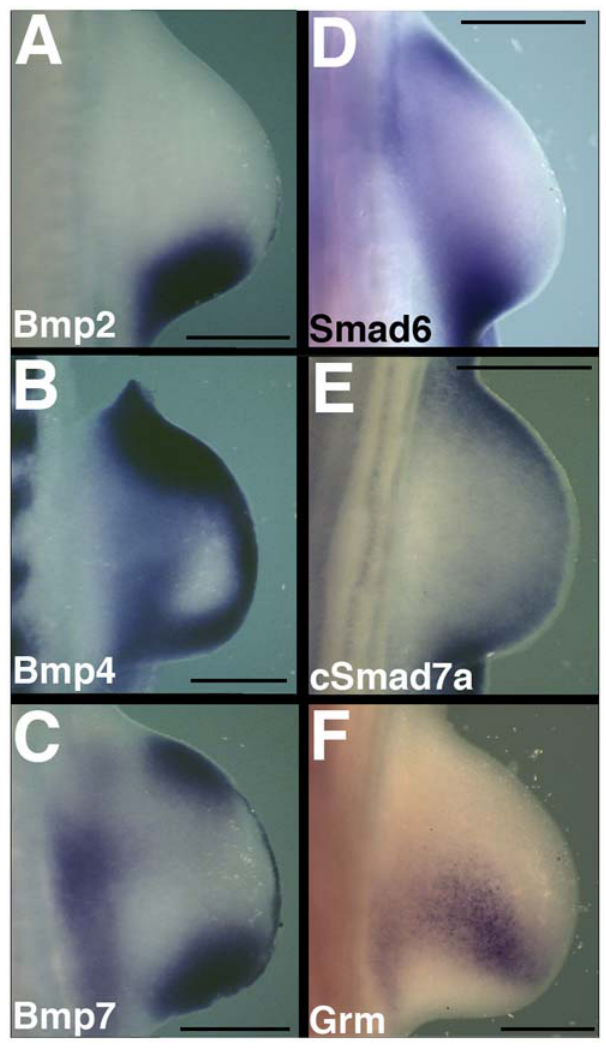
Figure 4. Negative Smad gene expression is restricted to areas of high BMP expression. Expression of BMP and negative Smad genes in HH St20 forelimb buds. Bmp2 (A), Bmp4 (B), Bmp7 (C), cSmad6 (D), cSmad7a (E), Gremlin (F). All images show dorsal surface. Anterior to the top, distal to right. Scale bars 500 m m.